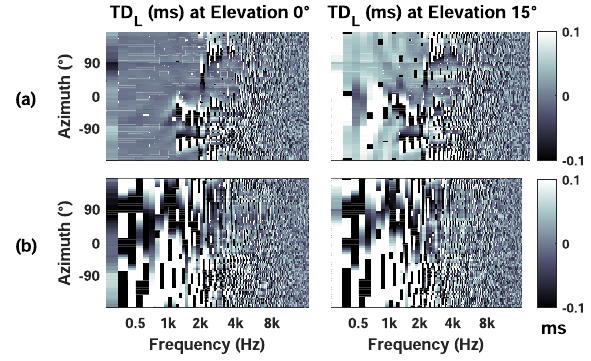
Figure 11. Resulting temporal distortion (TD) at elevations 0 (cid:3) and 15 (cid:3) for spectral weights calculated with (a) V0/ b 0 , and (b) V0 ± 15/ b 0 . Results are shown for the left ear of subject 1.